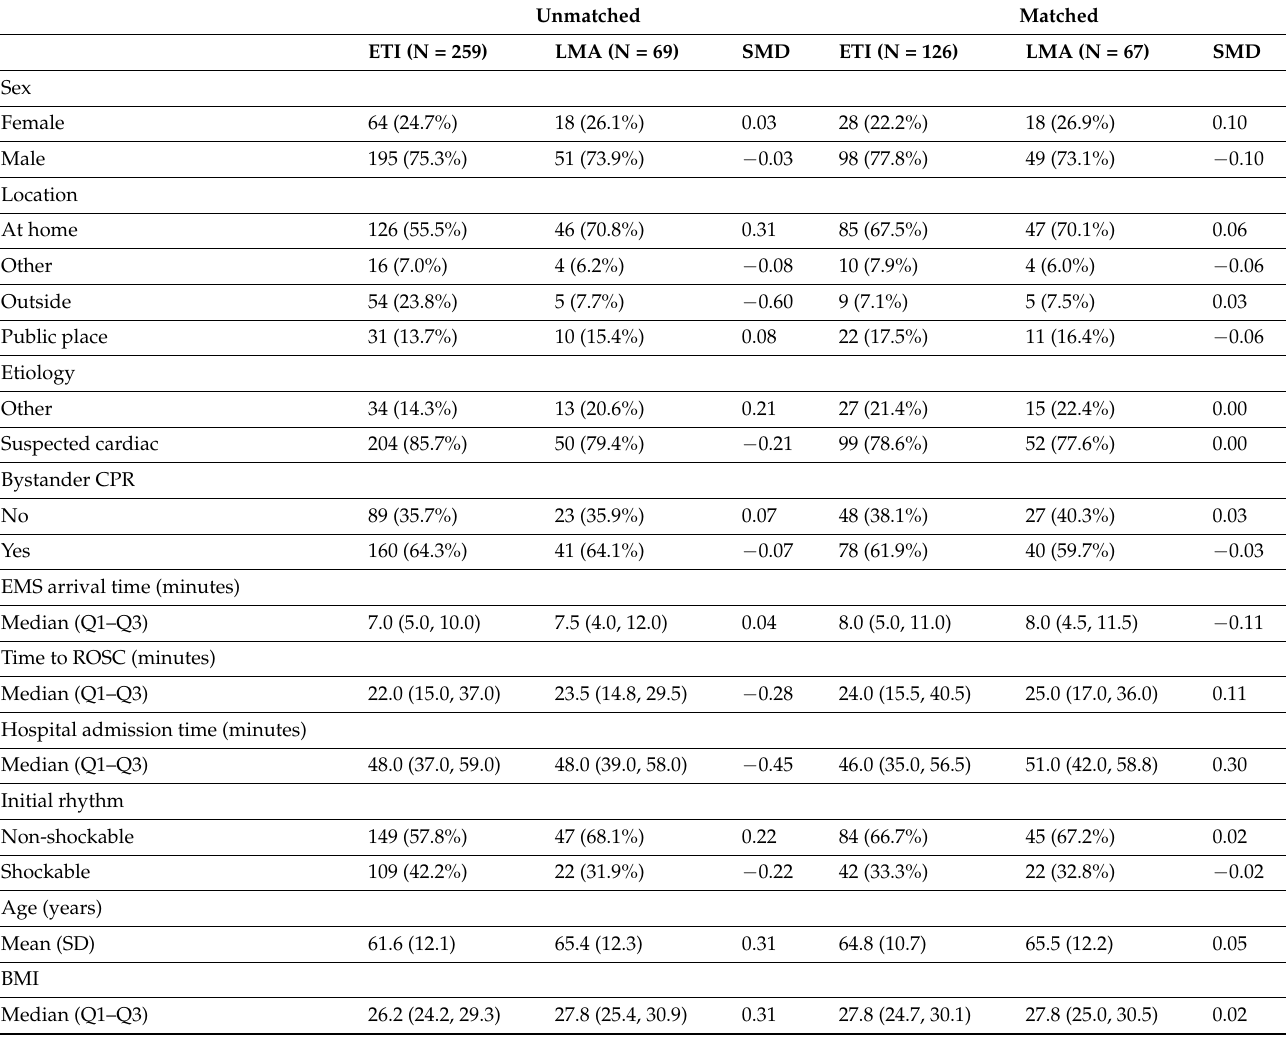
Table 1. Demographics before and after propensity score matching. Data after propensity score matching corresponded to that of one of the five imputed datasets that were generated follow- ing multiple imputation by chained equations (mice). Abbreviations: BMI = body mass index, CPR = cardiopulmonary resuscitation, EMS = emergency medical services, ETI = endotracheal intu- bation, SD = standard deviation, SGA = supraglottic airway, SMD = standardized mean difference, Q1 = first quartile, Q3 = third quartile.